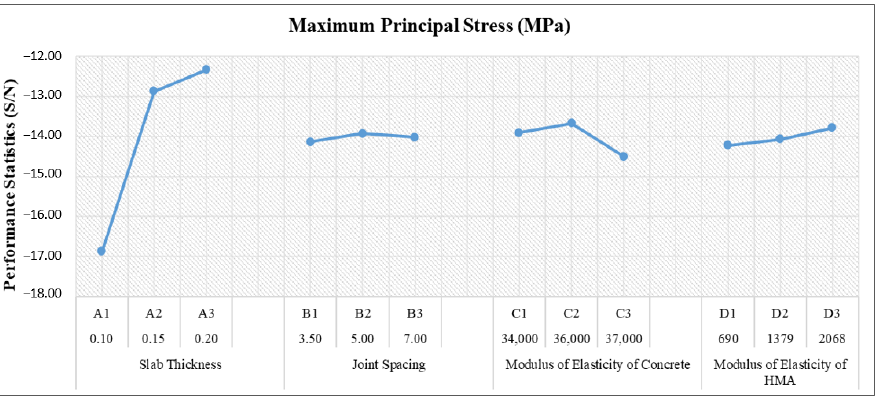
Figure 13. Performance statistics for all levels.